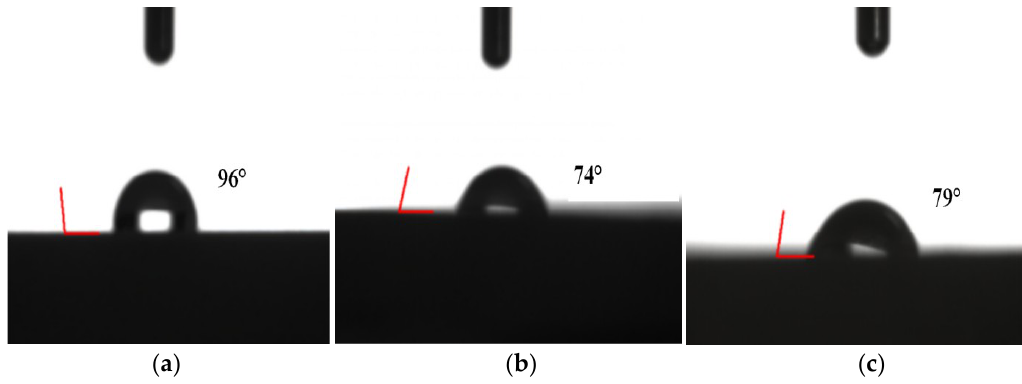
Figure 7. Testing photographs of the water contact angle of silicone rubber. ( a ) Original; ( b ) H 2 O 2 treated; ( c ) KOH treated.